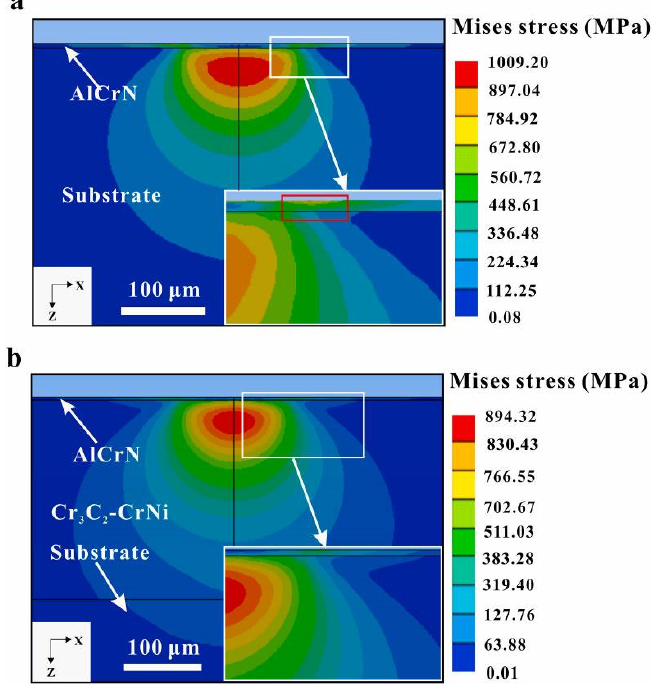
Figure 6. Mises stress distribution of ( a ) PVD coating and ( b ) HVOF-PVD duplex coating. Reprinted with permission from Ref. [56]. Copyright Elsevier,